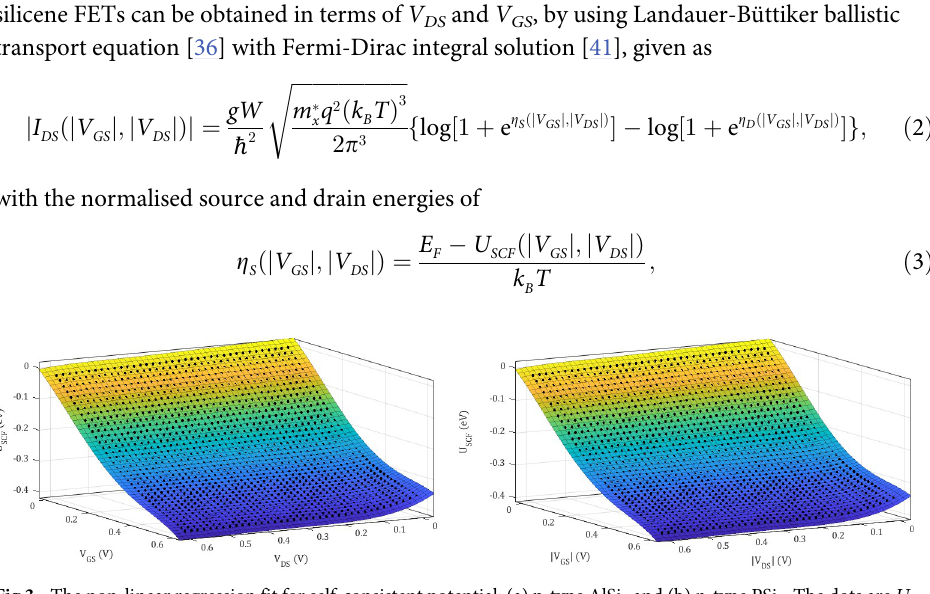
Fig 3. The non-linear regression fit for self-consistent potential: (a) p-type AlSi 3 and (b) n-type PSi 3 . The dots are U SCF data from ToB model; and the coloured plane is the plot of fifth order polynomial